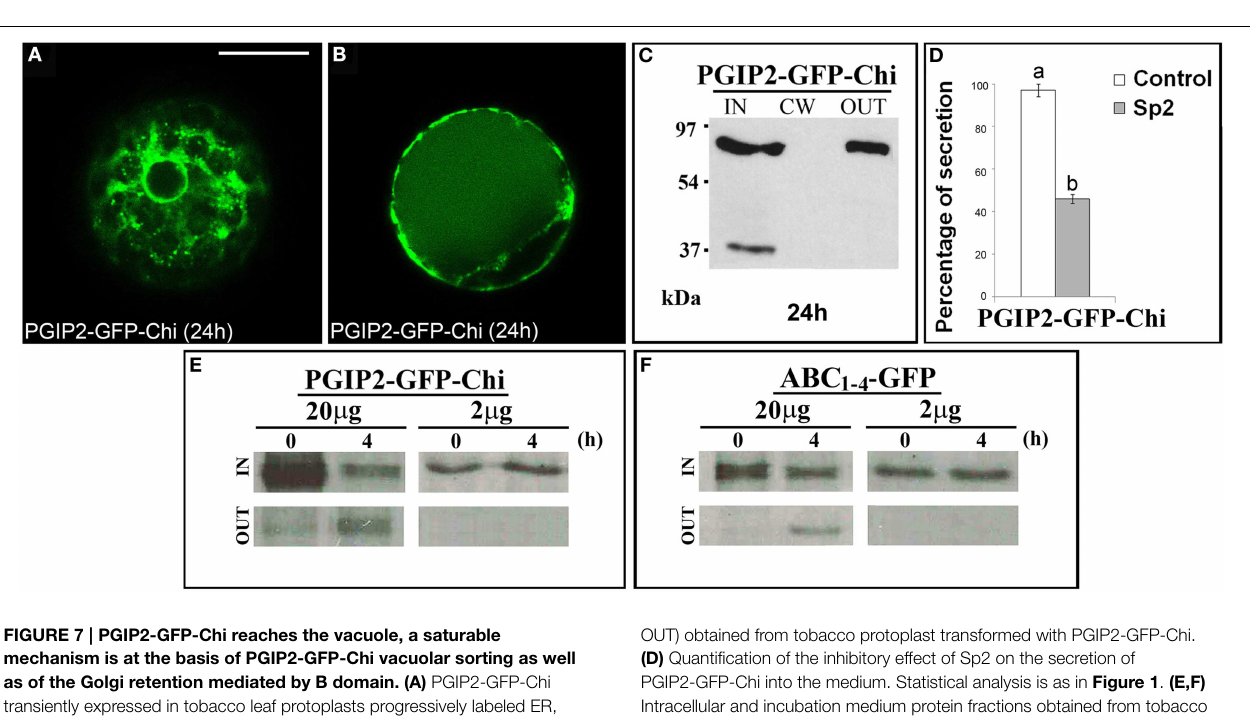
FIGURE 7 | PGIP2-GFP-Chi reaches the vacuole, a saturable mechanism is at the basis of PGIP2-GFP-Chi vacuolar sorting as well as of the Golgi retention mediated by B domain. (A) PGIP2-GFP-Chi transiently expressed in tobacco leaf protoplasts progressively labeled ER, Golgi stacks and (B) the large central vacuole. The same fluorescent pattern was observed in 96 ± 4% among over 300 transformed protoplasts examined (100 for each of three independent transformations). (C) Western blot of protein fractions (intracellular, IN; cell wall, CW; incubation medium,